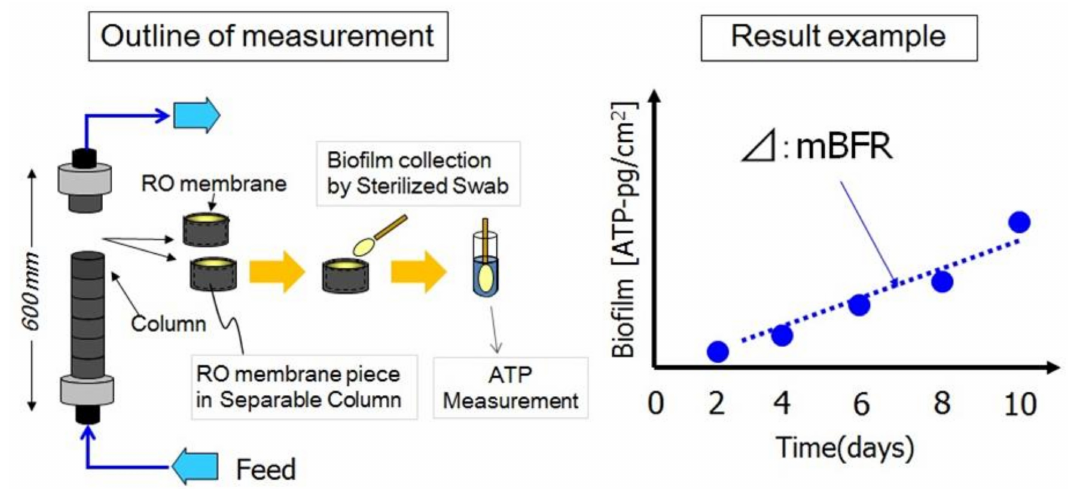
Figure 2. The schematic apparatus and method for the measurement of